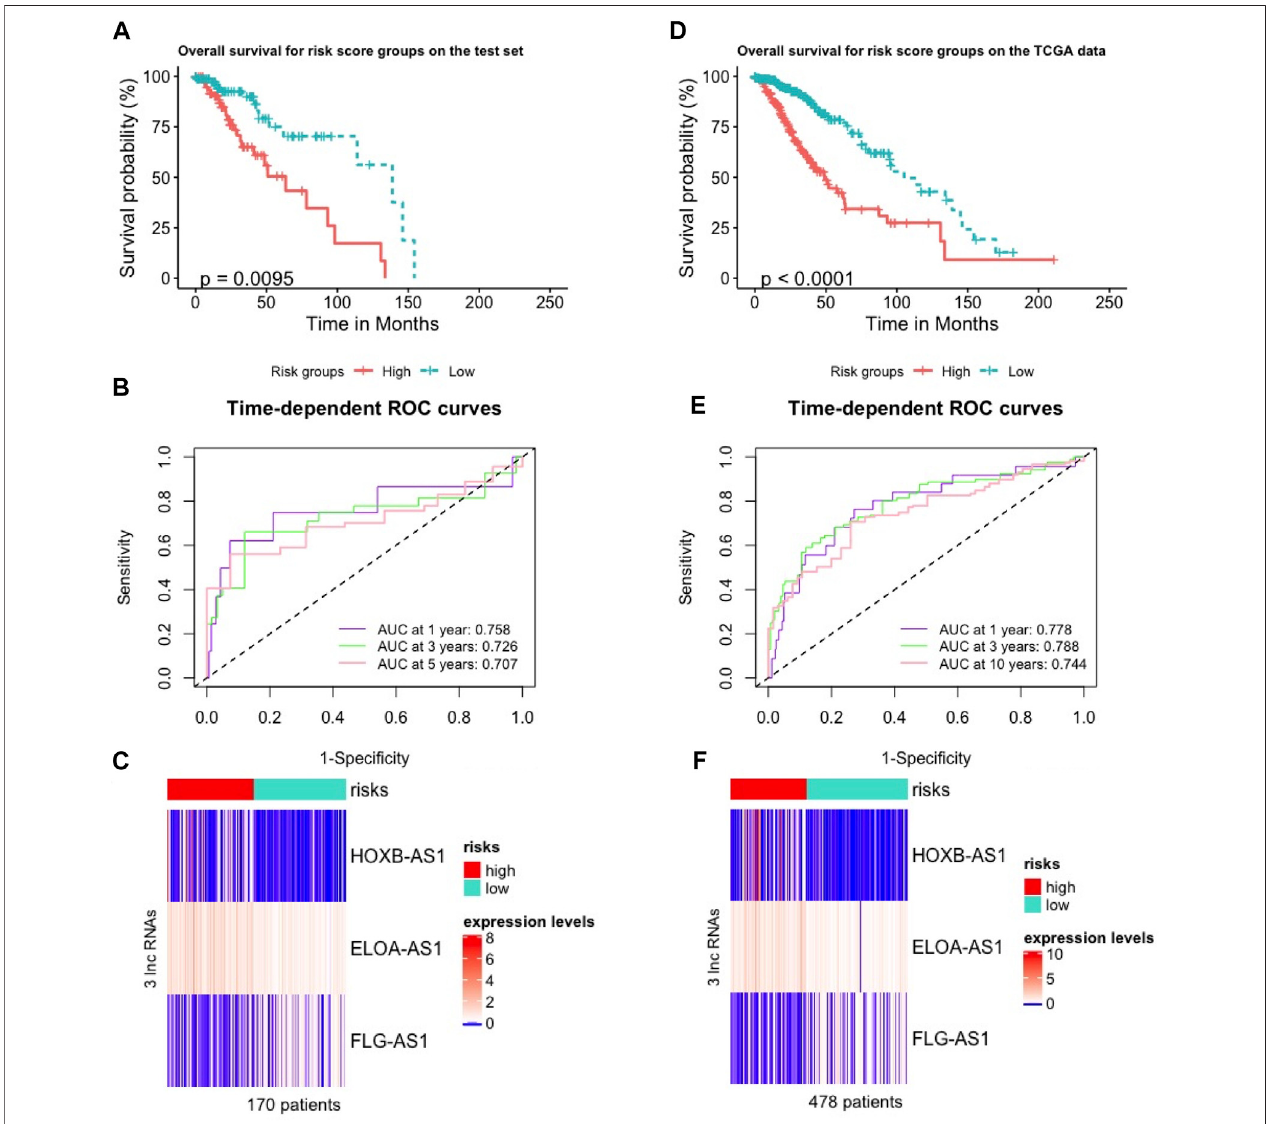
FIGURE 2 | Validation of the m6A-lncRNA signature used to predict outcomes in the test and TCGA sets. (A,D) Validation of OS in low- or high-risk patients predicted by m6ALncSig with Kaplan-Meier estimates on the test set (A) and the parental TCGA data (D) . (B,E) Time-dependent ROC curves of GILncSig at one, three and 5 years on the test set (B) and the parental TCGAdata (E) . (C,F) Variations in expression levels ofthe three hub m6A-LncRNAs between the two riskgroups on the test set (C) and the parental TCGA data (F) .